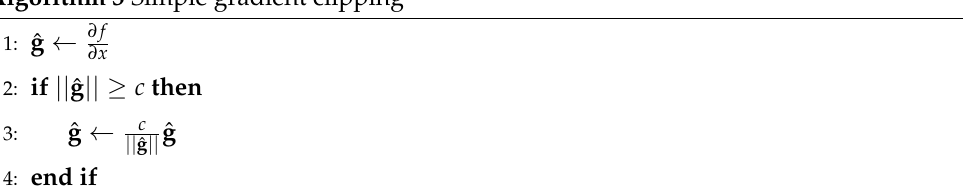
Algorithm 3 Simple gradient